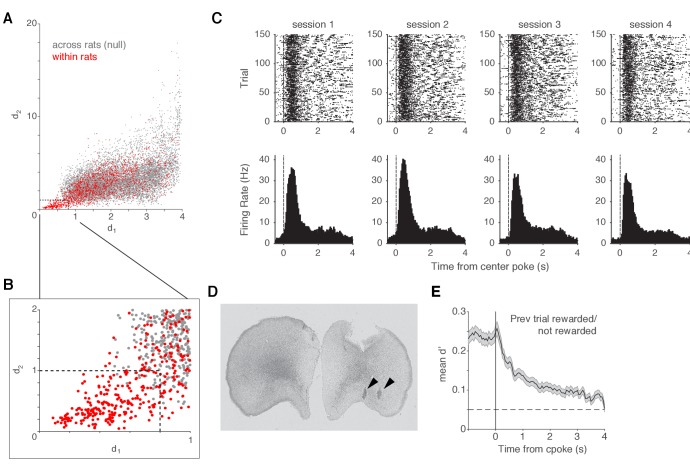
Method for identifying putatively identical waveforms over days.(A) Distribution of d1 and d2 values comparing waveforms across rats produces a null distribution (gray, see Materials and methods). Distribution of values comparing waveforms within rats from subsequent recording sessions (red). Dashed lines are empirically chosen thresholds. (B) Subplot from panel A. (C) Neuron that was identified as putatively identical across four recording sessions. Raster plots only show 150 trials (out of 400–600 each day) for display purposes (upper panels). PSTHs (derived from all trials) are shown below (lower panels). (D) Figure 2B was reproduced combining putatively identical units recorded over multiple days. Mean discriminability index (d’) depending on whether the previous trial was rewarded or not, computed in 50 ms bins. Error bars are ± s.e.m.